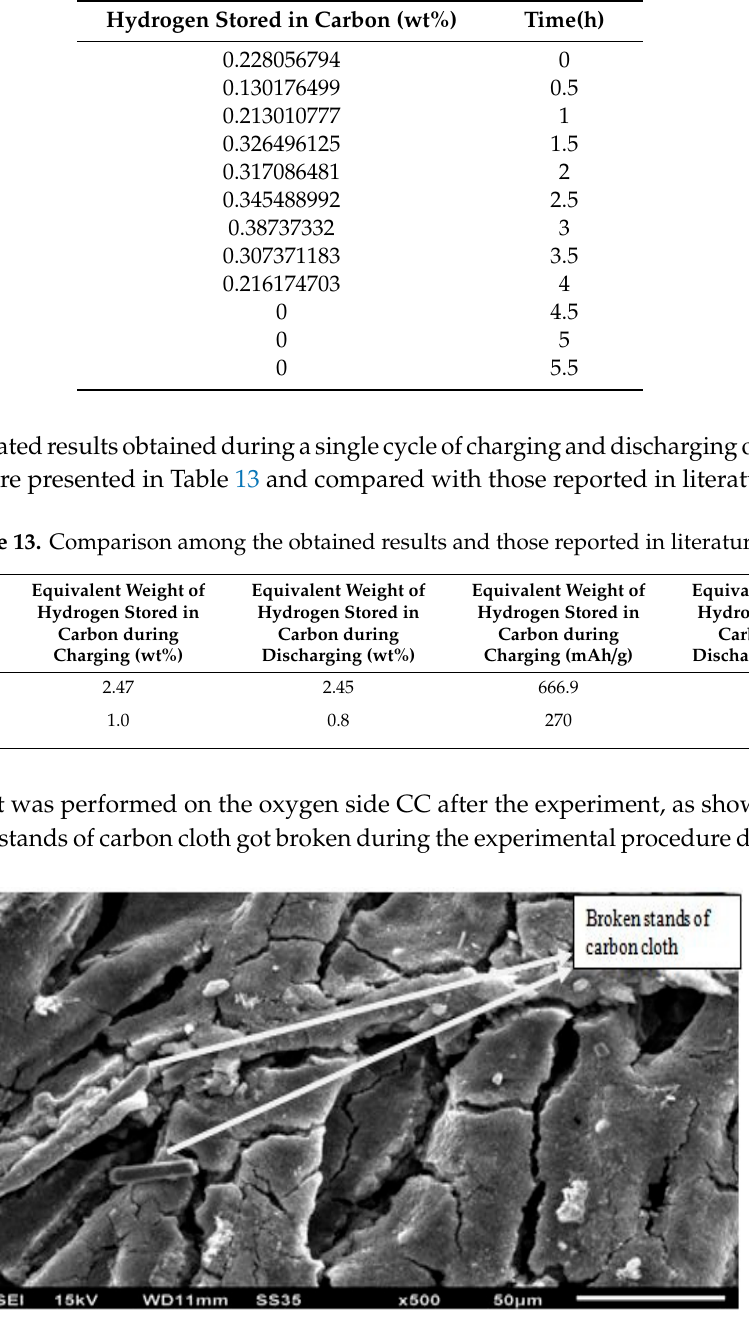
Table 12. X and Y axis variable values of the active points shown in Figure 17.